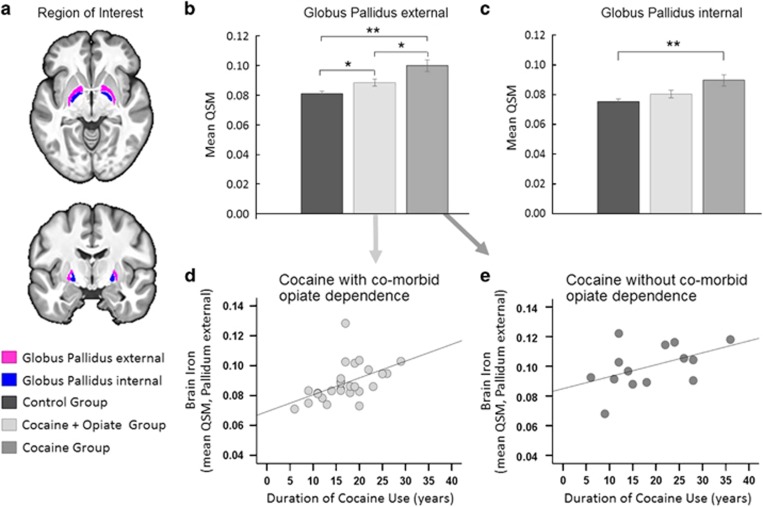
Cocaine-related abnormalities. (a) Illustration of the globus pallidus (GP), which was our region of interest. (b) Post hoc comparison of iron concentration in the GPe revealed significant differences between the groups, such that QSM levels in CUD patients with comorbid opiate dependence fell midway between the levels seen in healthy volunteers and CUD patients without comorbid opiate dependence. (c) Iron concentration in the GPi differed significantly between the groups, which was driven by significantly increased QSM in CUD patients without opiate dependence compared with healthy control volunteers. (Error bars denote s.e.m., **P < 0.005 and *P < 0.05). (d, e) In both CUD subgroups, excessive iron accumulation in the GPe was associated with the duration of cocaine use, supporting the notion that chronic cocaine use is implicated in the observed pathology. No relationships were observed between iron concentration in the GPi and the duration of cocaine use or with the duration of opiate use (for statistical details see text and Supplementary Material). CUD, cocaine use disorder; GPe, external GP; GPi, internal GP; QSM, quantitative susceptibility maps.